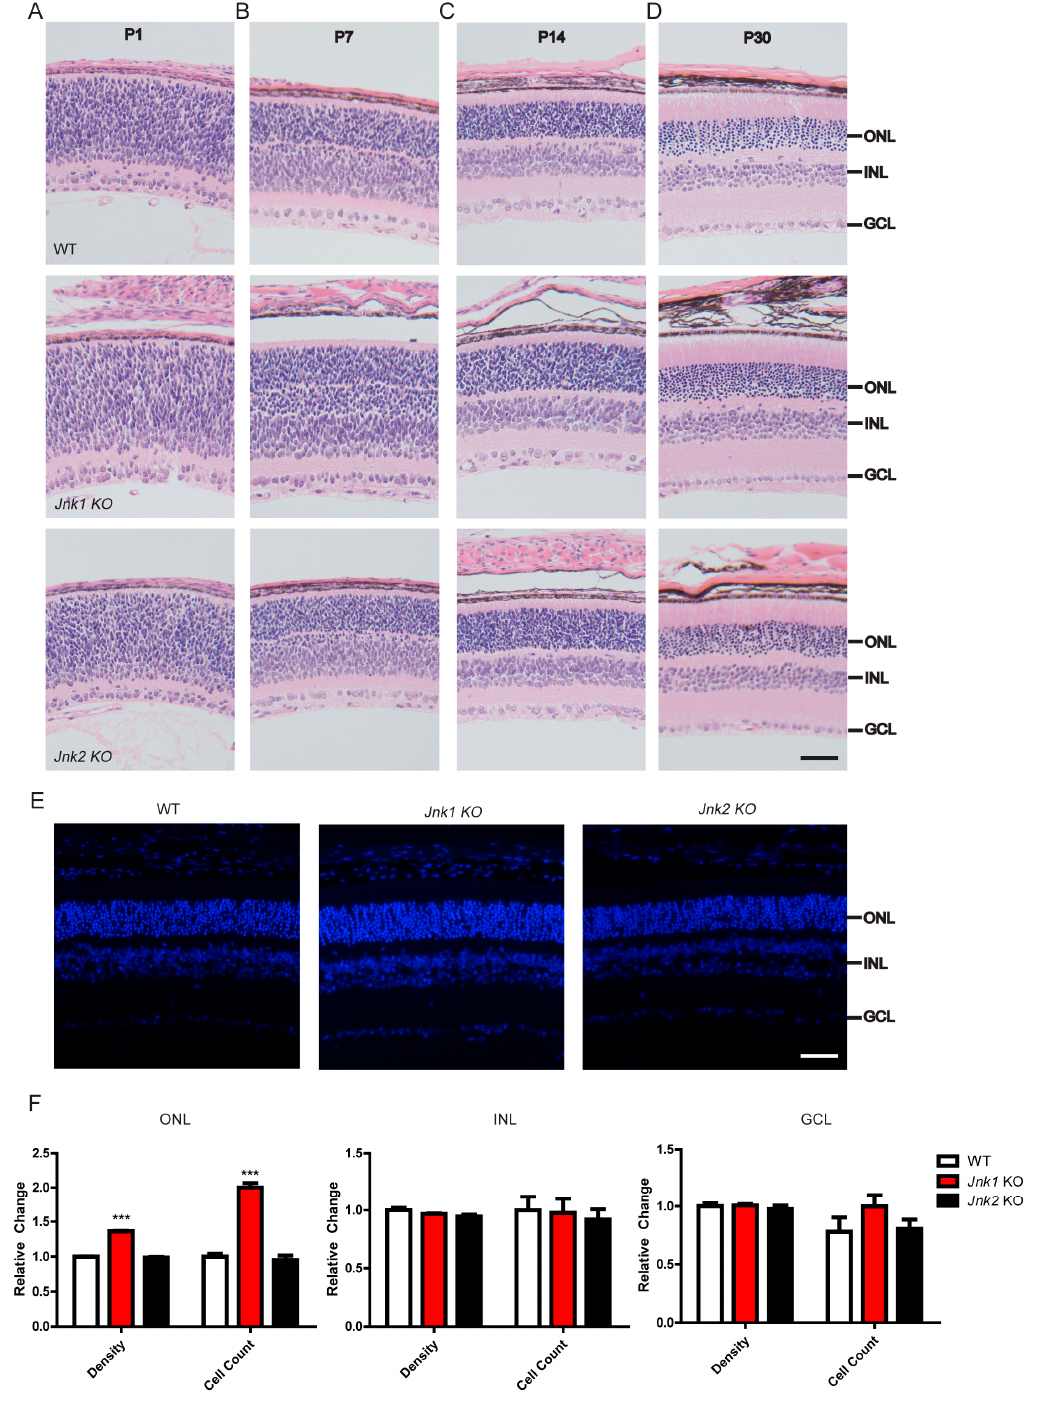
Figure 1. JNK1 ablation led to an increase in the outer nuclear layer (ONL). ( A – D ) Hematoxylin and eosin (H & E) staining of wild-type (WT), Jnk1 knockout (KO), and Jnk2 KO retinal sections from P1, P7, P14, and P30 mice. Scale bars: 50 μ m. ( E ) WT, Jnk1 KO, and Jnk2 KO retinal sections from P30 mice were stained with DAPI (DNA-binding dye, 4',6-diamidino-2-phenylindole) and imaged by immunofluorescence microscopy. Scale bars: 50 μ m. ( F ) The density and cell number of the ONL, inner nuclear layer (INL), and ganglion cell layer (GCL) were quantified from equally sized fields in similar retinal regions for each retina at P30. The results are presented relative to wild-type retinal sections. Graphs show the mean ± SEM (Standard error of the mean), and the data shown are representative of three retinas. *** p < 0.001 (Wilcoxon–Mann–Whitney test).